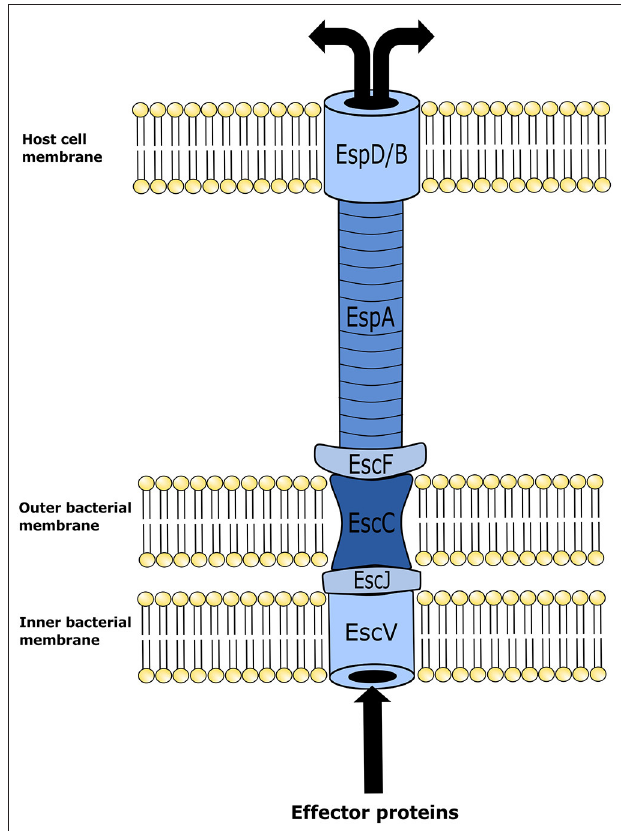
FIGURE 1 | Illustration of enterohemorrhagic Escherichia coli (EHEC) type three secretion system structure. This mechanism is utilized by EHEC to introduce effector proteins into the host cell. Upon locus of enterocyte effacement (LEE) activation, the proteins EscV and EscC establish themselves in the inner and outer membranes of the bacterium, respectively, forming an annular complex. The structural lipoprotein EscJ is then placed within the periplasmic space between EscV and EscC. In conjunction, these proteins make a corridor on the bacterial membrane for effector proteins to be transported out of the cell. In turn effector proteins are moved from the bacterial membrane into the host cell using a needle-like structure that is elongated from the bacterial membrane structure to an annular complex formed in the host cell membrane. This needle-like structure is comprised of the E. coli secreted proteins, EscF and EspA. EspA forms bonds with EscF, and polymerizes into the hollow needle-like structure that extends out and allows the connection with the host cells of the intestinal epithelium. In combination with EspA, protein EspB and EspD form a pore on the cell membrane of the host epithelial cell. Effector proteins then travel through the fully formed secretion system from the bacterium into the host